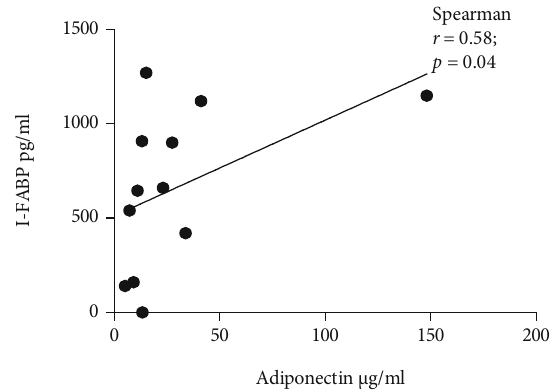
Figure 3: Correlation between I-FABP and adiponectin level in the GDM group. The data for adiponectin level were available in 12 GDM samples.